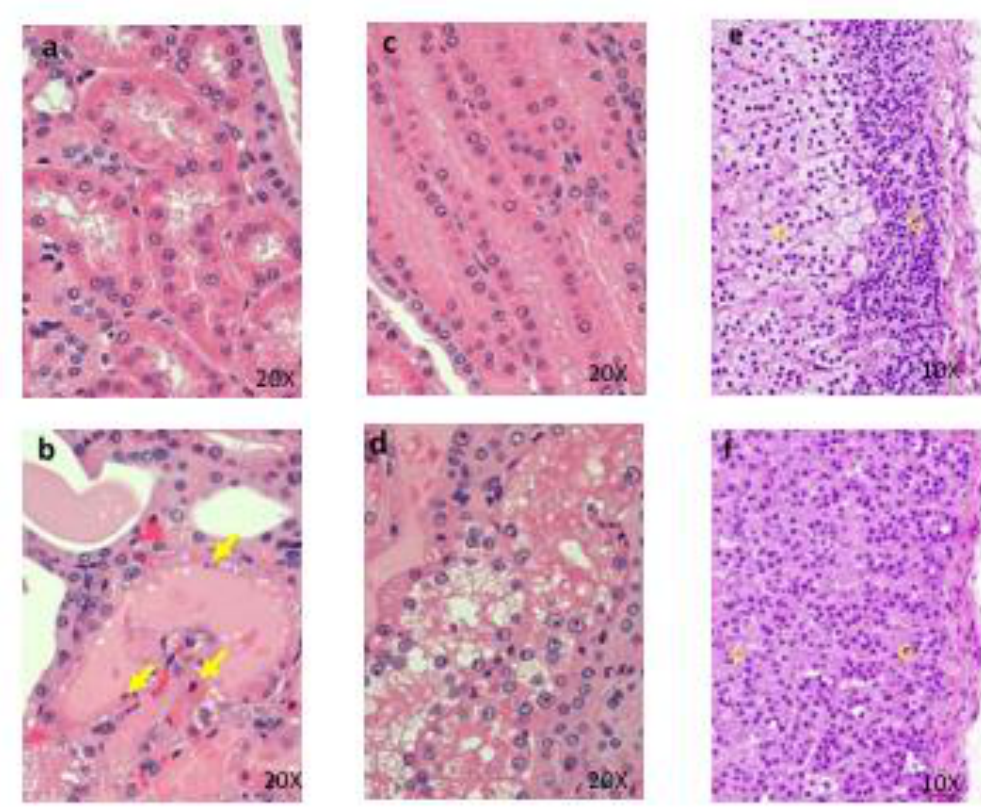
Figure 7: Histopathological findings of proximal convoluted tubules in kidney. Control (a), 1000 mg/kg (b) , a , No abnormalities detected. b , Degeneration and necrosis (arrows) of proximal convoluted tubular epithelium are seen. Histopathological findings of proximal straight tubules in kidney. Control (c), 1000 mg/kg (d), c , No abnormalities detected. d , Degeneration and necrosis of proximal convoluted tubular epithelium are seen. Histopathological findings in adrenal. control (e), 1000 mg/kg (f), e , No abnormali- ties detected, f , Hypertrophy of the cortical cells at glomerulosa are seen. g: zona glomerulosa, f: zona